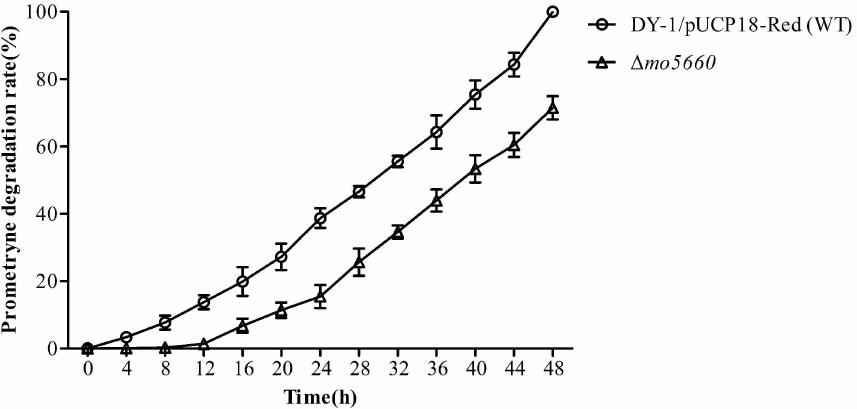
Figure 10. Degradation rates of prometryne by strains WT and ∆ mo5660 . The error bar indicates one standard